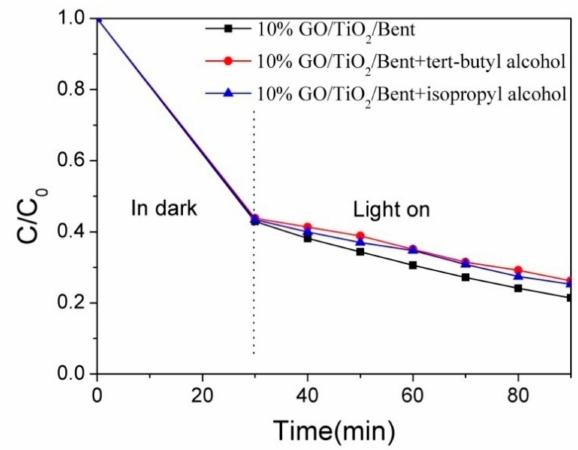
Figure 13. E ff ect of radical quenching agents on MB degradation by 10% GO / TiO 2 / Bent (Concentration of MB: 100 mg / L).